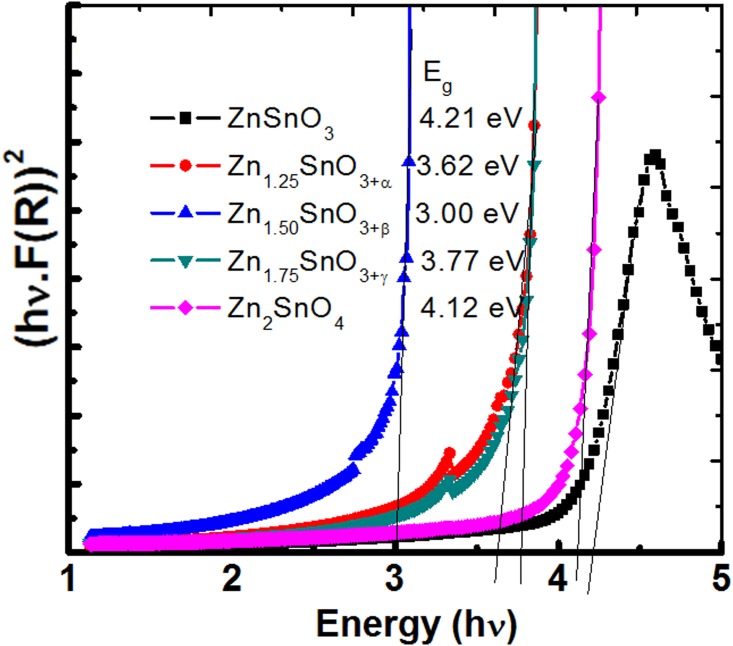
Band gap estimation of ZnSnO3, Zn1.25SnO3+α, Zn1.5SnO3+β, Zn1.75SnO3+γ, Zn2SnO4 nano-crystallites from diffused reflectance spectra (S1 Fig) obtained by decomposition of the gel product at 650°C for 3h.